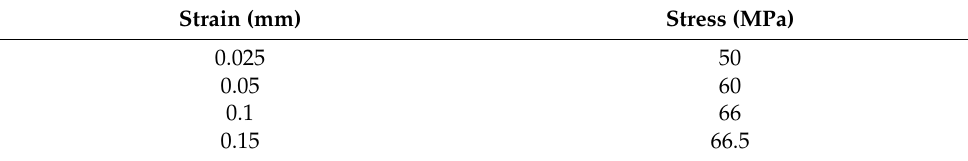
Table 1. The short-term stress-strain curve of delrin100 at temperatures under 23 ◦ C. Strain (mm) Stress (MPa)